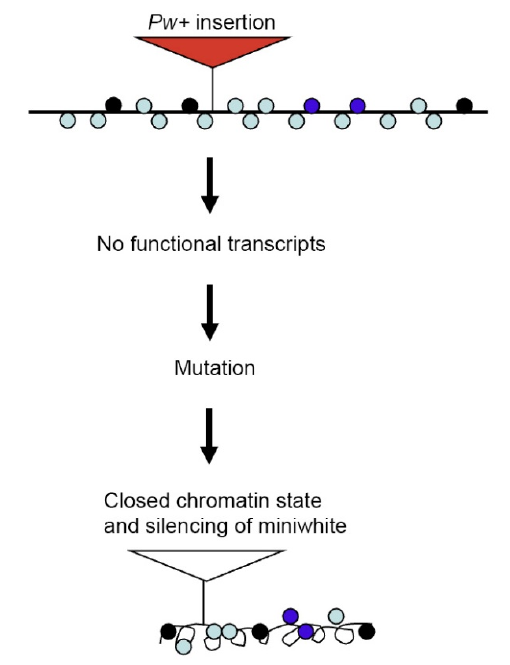
Figure 7. Pw + silencing by perturbation of a positive RNA feedback mechanism. The insertion of a Pw+ reporter within the Yeti gene affects its expression. According to a positive RNA feedback model, the consequent lack of functional Yeti transcripts would induce the formation of a closed chromatin structure of the gene itself. As a result, the mini ‐ white gene is silenced. Colored circles represent different chromatin marks.